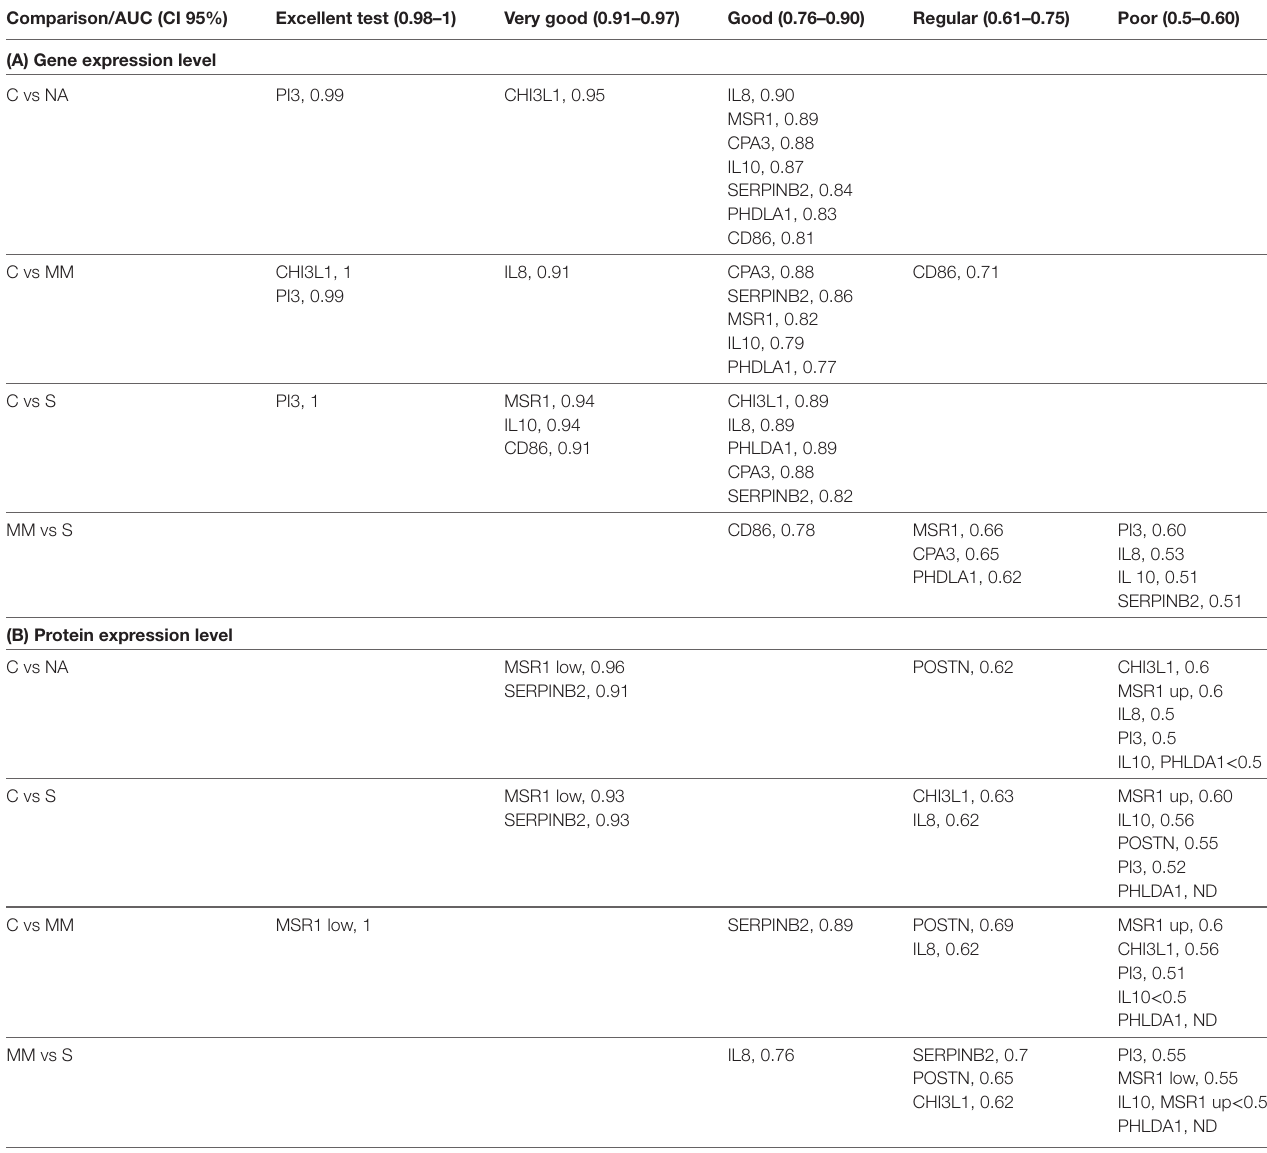
TaBle 2 | Classification of biomarkers by the receiver operating characteristic (ROC) curves analysis. comparison/aUc (ci 95%)